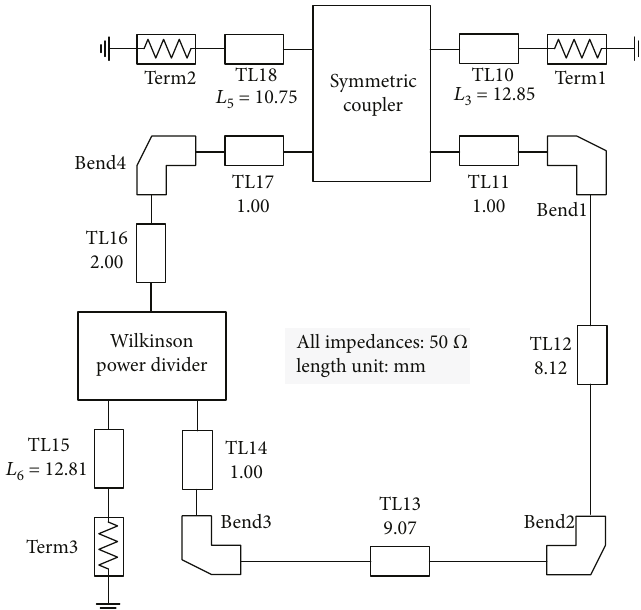
Figure 4: Schematic of the three-way divider with C = 7 dB and K = 1 in ADS.